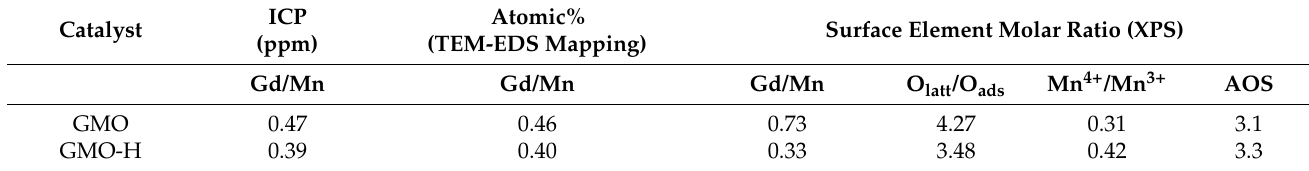
Table 1. ICP results, TEM-EDS mapping, and surface elemental composition (XPS) of GMO,